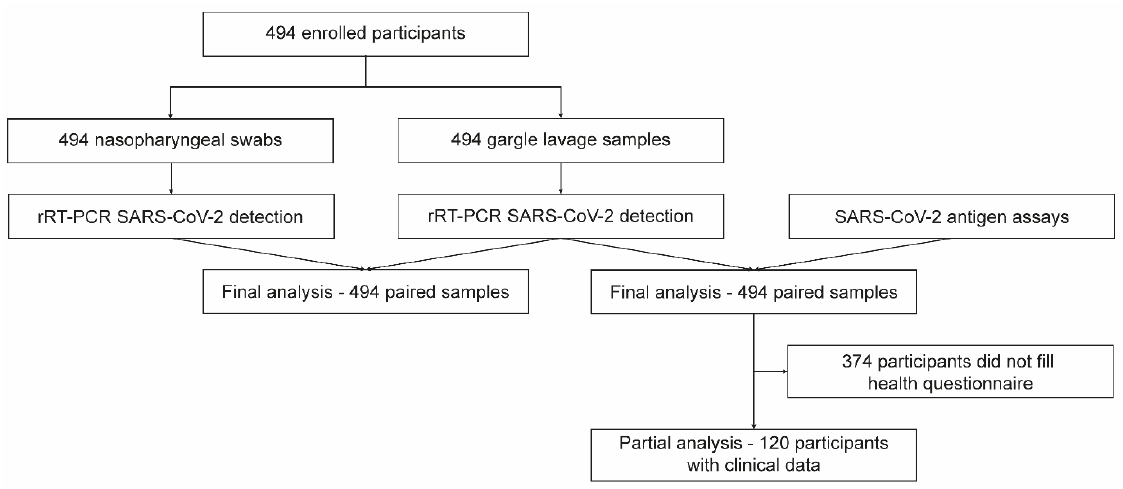
Figure 1. Flowchart of the study.